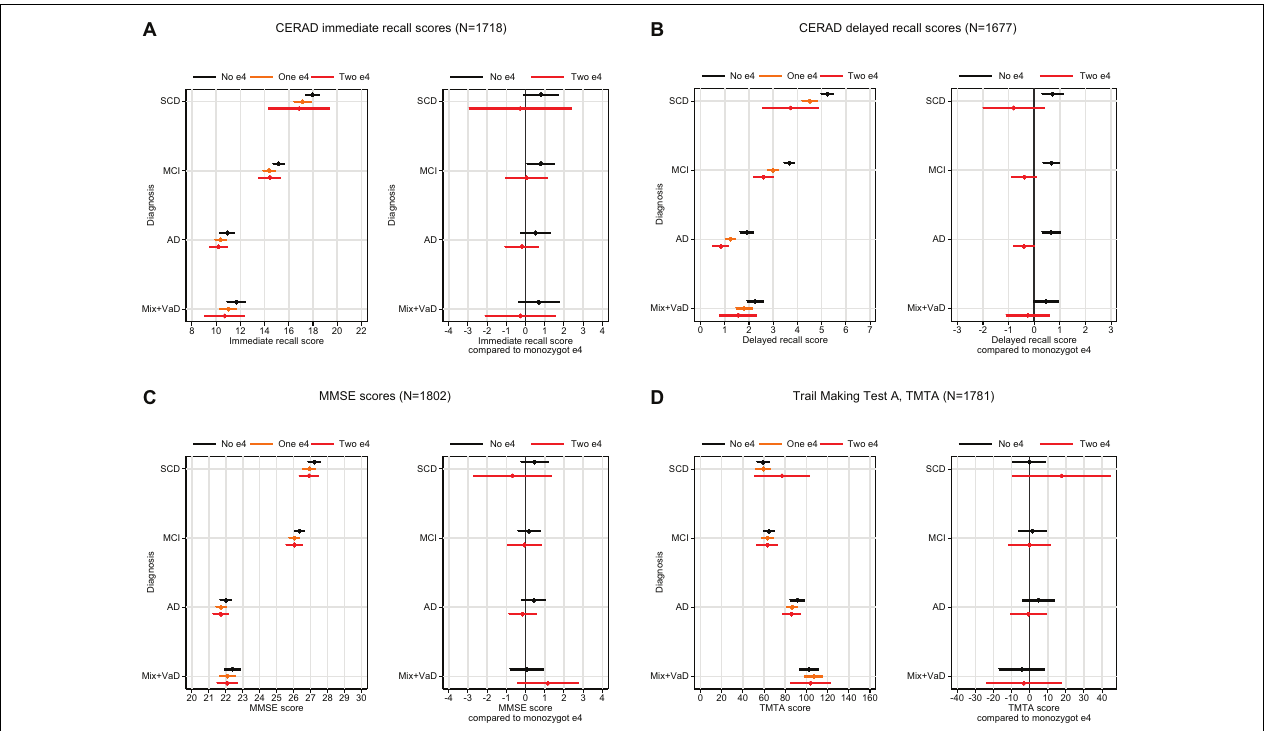
FIGURE 1 | Mean cognitive scores on four cognitive tests (A–D) (with 95% CI bands) by e4 status and diagnosis (left panel), and predicted difference in cognitive scores for those without the e4 allele or homozygote e4 compared to those with monozygotic e4 (right